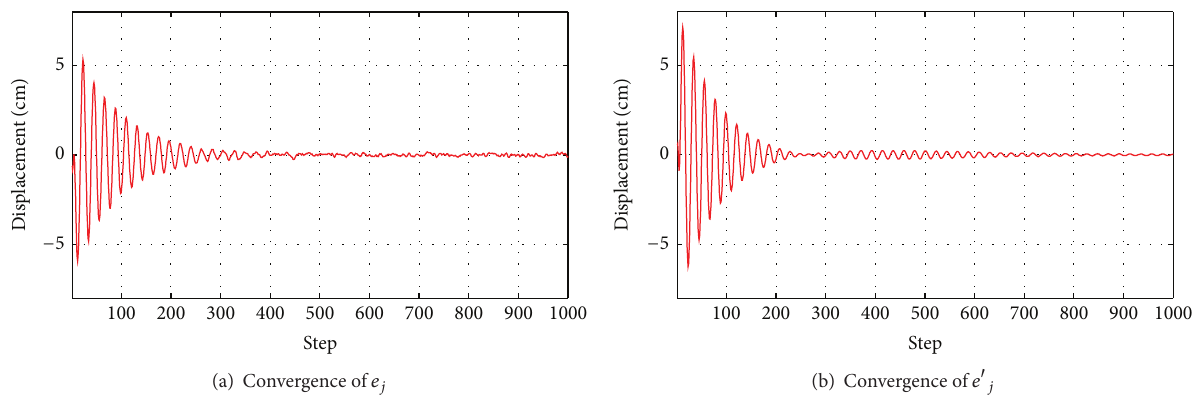
Figure 15: LMS algorithm convergence process.